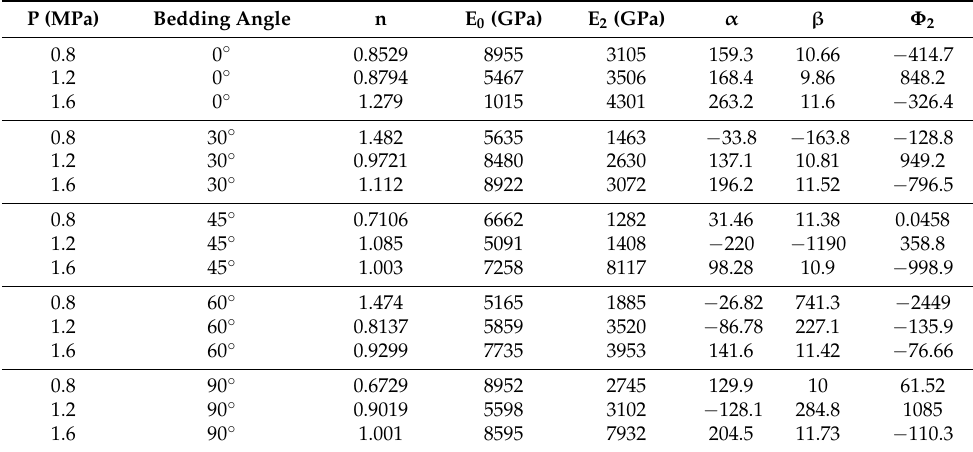
Table 4. Parameters of the rock constitutive